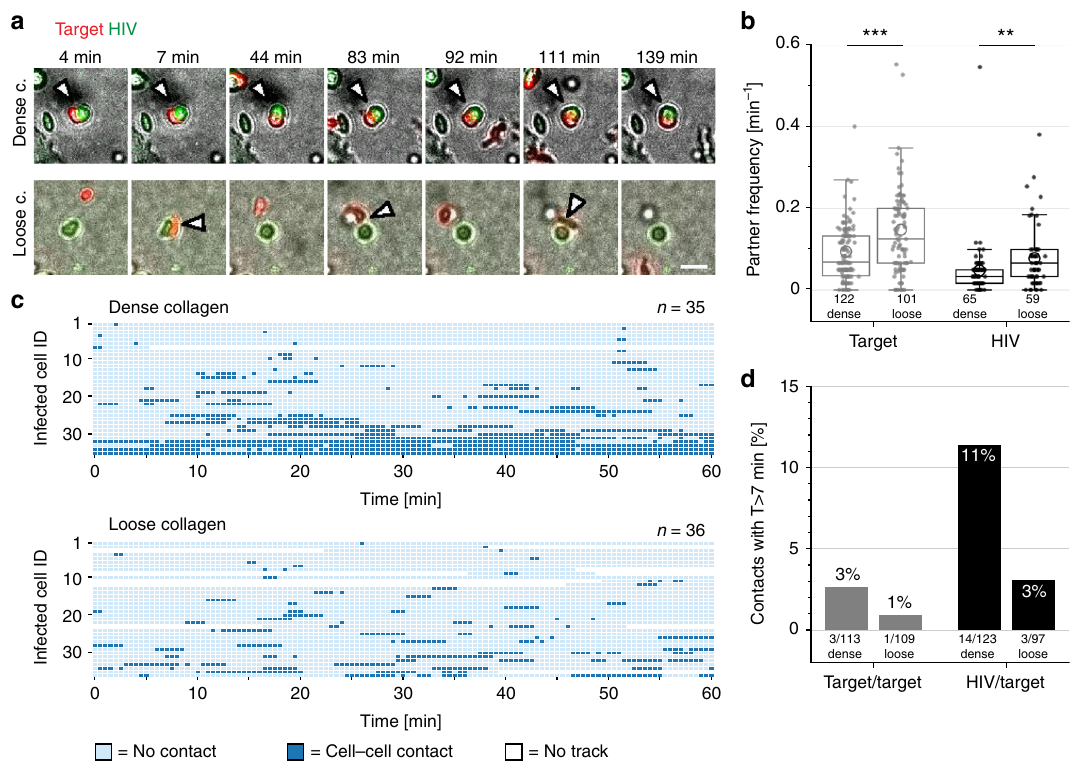
Fig. 5 Step 5: Cell contact analysis in different collagen densities. Contact analysis of target CD4 T cells in co-culture with HIV-1 infected donor cells. Mock CD4 T cells and puri fi ed HIV-1 infected cells were stained with red and green PKH cell dyes, respectively, mixed and embedded in loose or dense collagen. Cells were imaged every 30 s, segmented and tracked for 60 min. a Still images of supplementary movie 3 recorded at the indicated times. Green: HIV-1 infected cell (HIV), red: target CD4 T cell (target). Contacts are indicated by an arrowhead. Scale bar 20 µ m. b Partner frequency per min of target or donor cells with other cells in dense and loose collagen. Numbers indicate absolute cell number. The graph shows boxplots with Tukey style whiskers, circles indicate mean values. Mann – Whitney test was used for statistical analysis. c Contact diagram for donor cells with target cells in dense and loose collagen. Individual cell tracks are color coded: light blue, without contact; dark blue, in contact with another cell; white, the track has ended/not yet begun. d Frequency of contacts lasting longer than 7 min between two uninfected cells (target/target) or infected/uninfected cell pairs (HIV/target). Numbers indicate absolute cell contact